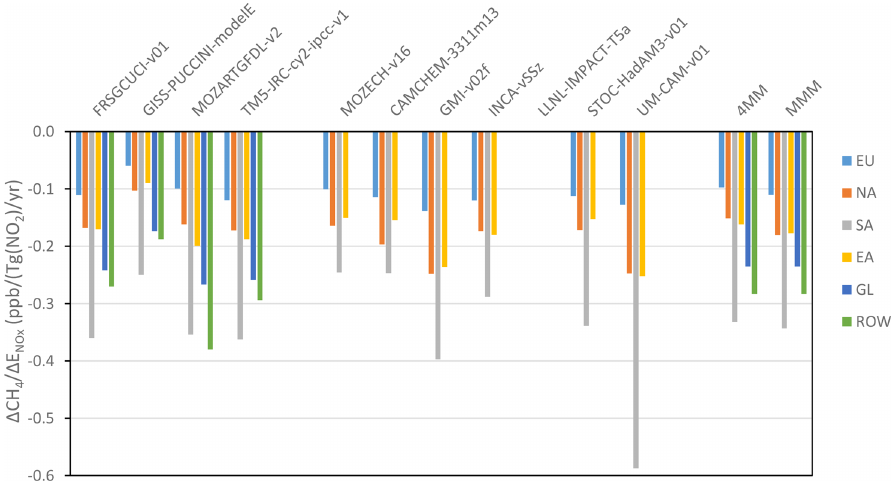
Figure 2. Sensitivity of global methane (ppb) to changes in anthropogenic NO x emissions (Tg(NO 2 )yr − 1 ), derived from 20% reduction experiments performed by the HTAP models for four regions (Europe, EU; North America, NA; South Asia, SA; and East Asia, EA), globally (GL), and for the ROW (everywhere outside of the four HTAP regions). Global (and hence ROW) results are only available for the four core models, shown on the left of the figure. Also shown are the 4MM and MMM. There are no results for the LLNL-IMPACT-T5a model for NO x ; it is included to maintain consistency with Figs. 3 and